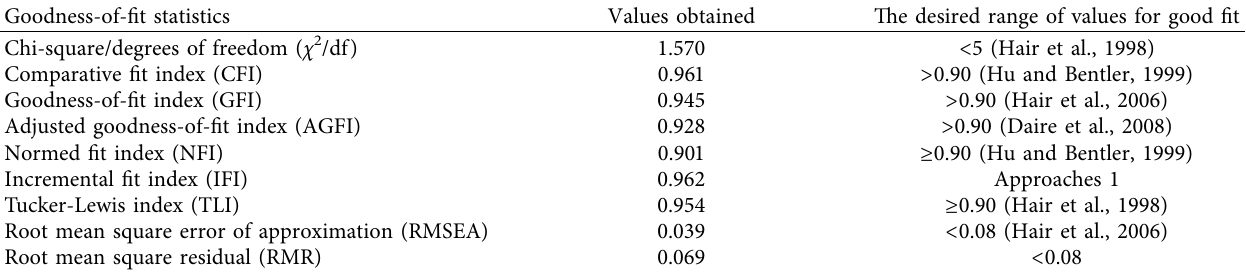
Table 6: Criteria for several fit